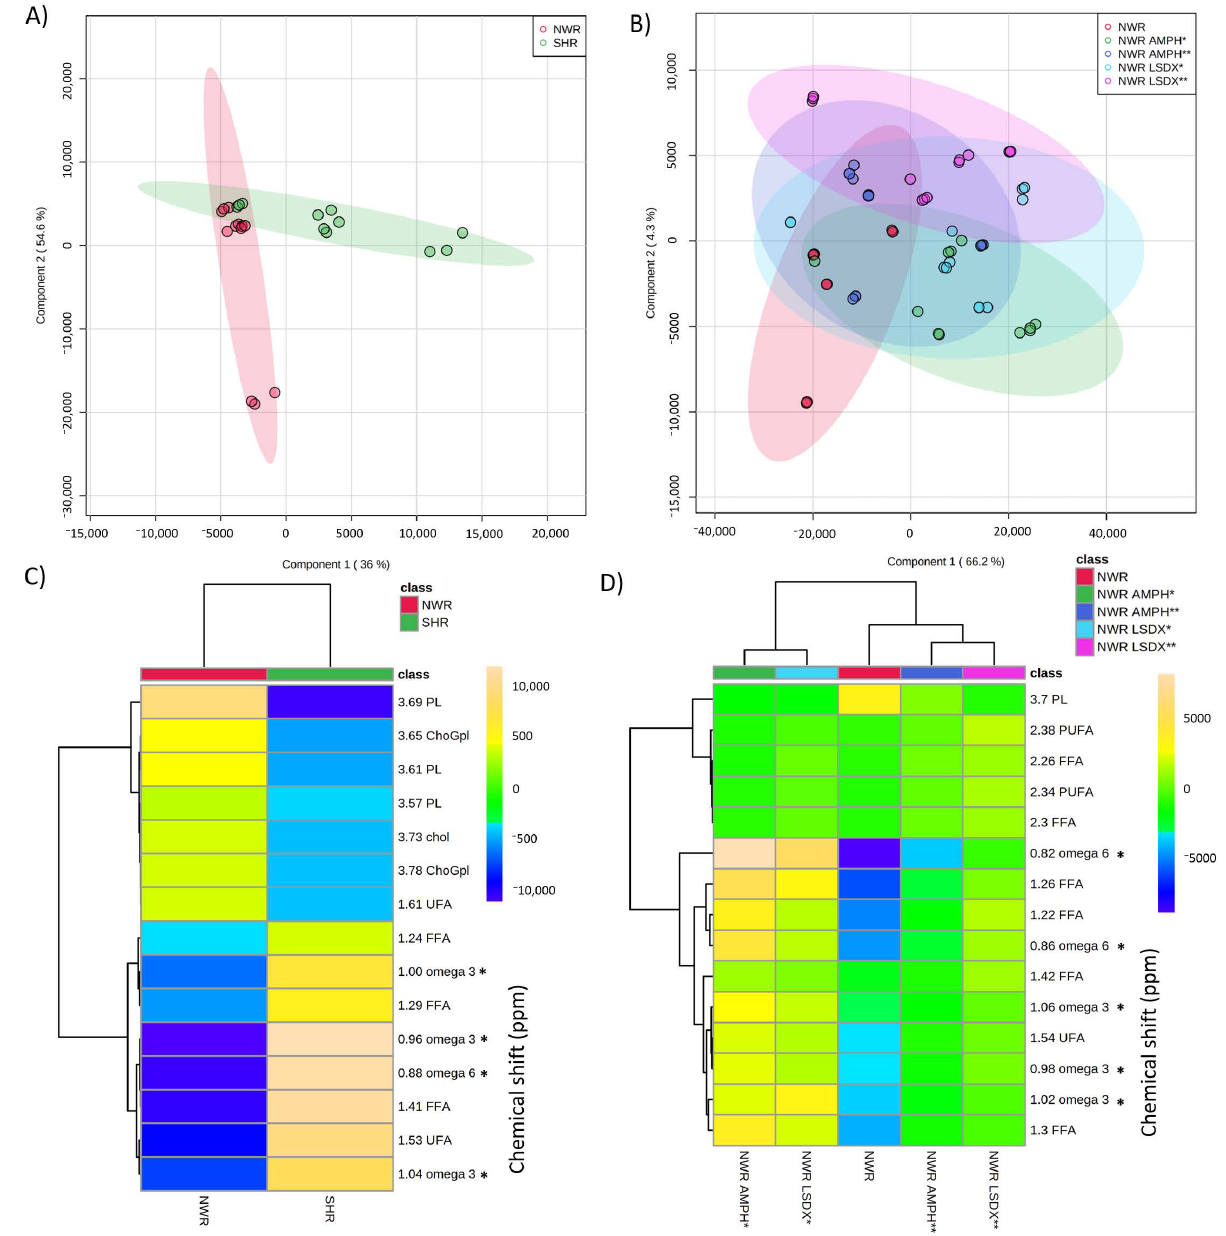
Figure 1. Partial least squares discriminant analysis (PLS-DA) on animal serum lipids 1 H-NMR data: ( A ) schizophrenia (SCZ) model (spontaneously hypertensive rat, SHR) vs. control (normotensive Wistar rat, NWR) score plot in PC 1 and PC 2. A total of 23 spectra were used for PLS-DA analysis of SHR against NWR, being four samples of each treatment in triplicate excluding one outlier (SHR group). ( B ) 3D score plot for evaluation in NWR of the effects on lipids of psychostimulants amphetamine (AMPH) or lisdexamfetamine (LSDX) with doses of (*) 0.5 mg/kg and (**) 5.0 mg/kg. A total of 62 spectra were used for PLS-DA analysis of NWR after AMPH or LSDX administration, with five samples for each treatment (four samples for NWR), performed in triplicate, but excluding three outliers in NWR-LSDX* group, three outliers in NWR-AMPH* group, two outliers of NWR-LSDX** group, and two outliers in NWR-AMPH** group. ( C ) Heatmap for SHR vs. NWR shows relative concentrations of the 15 most important variables in projection (VIP). ( D ) Heatmap for NWR vs. AMPH or LSDX shows the relative concentrations of the fifteen variables (VIP) before and after psychostimulants administration. In ( C , D ), chemical shifts marked for omega 3 *, omega 6 *, may come from other acyl groups. PL: phospholipids, ChoGpl: choline glycerophospholipids, chol: cholesterol, FFA: free fatty acids, PUFA: polyunsaturated fatty acids, UFA: unsaturated fatty